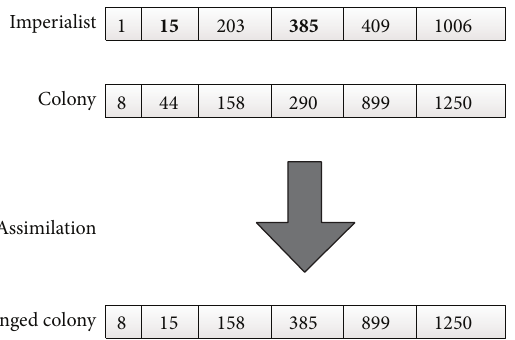
Figure 5: Assimilation